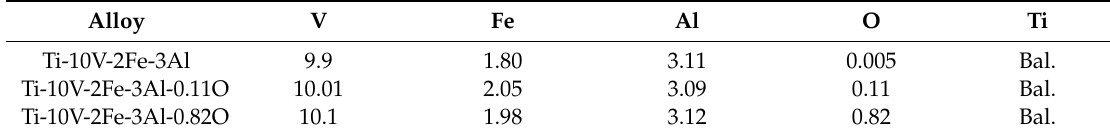
Table 1. Chemical composition of alloys (wt.%).